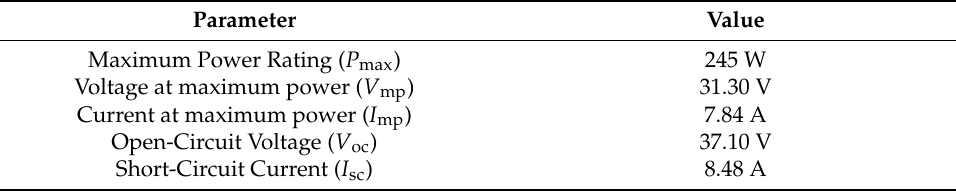
Figure 9. PV modules installed at SolarTech Lab , Politecnico di Milano. Table 2. Ratings of the PV module under